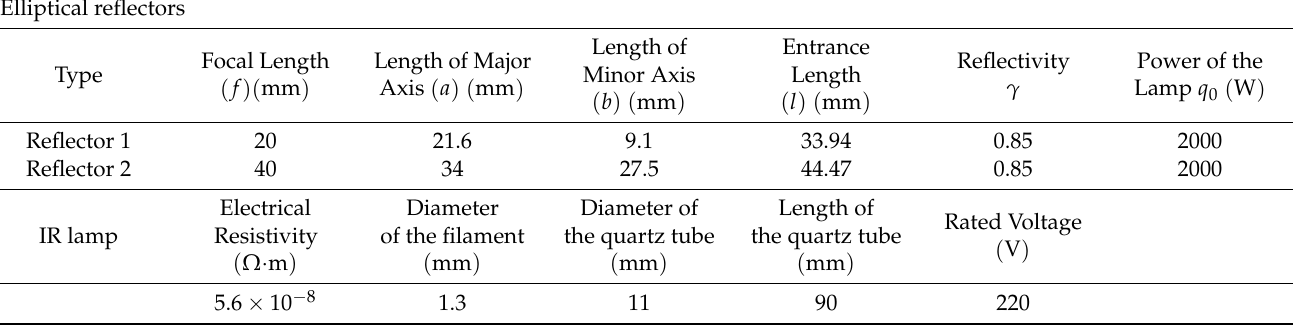
Table 2. Parameters of the IR